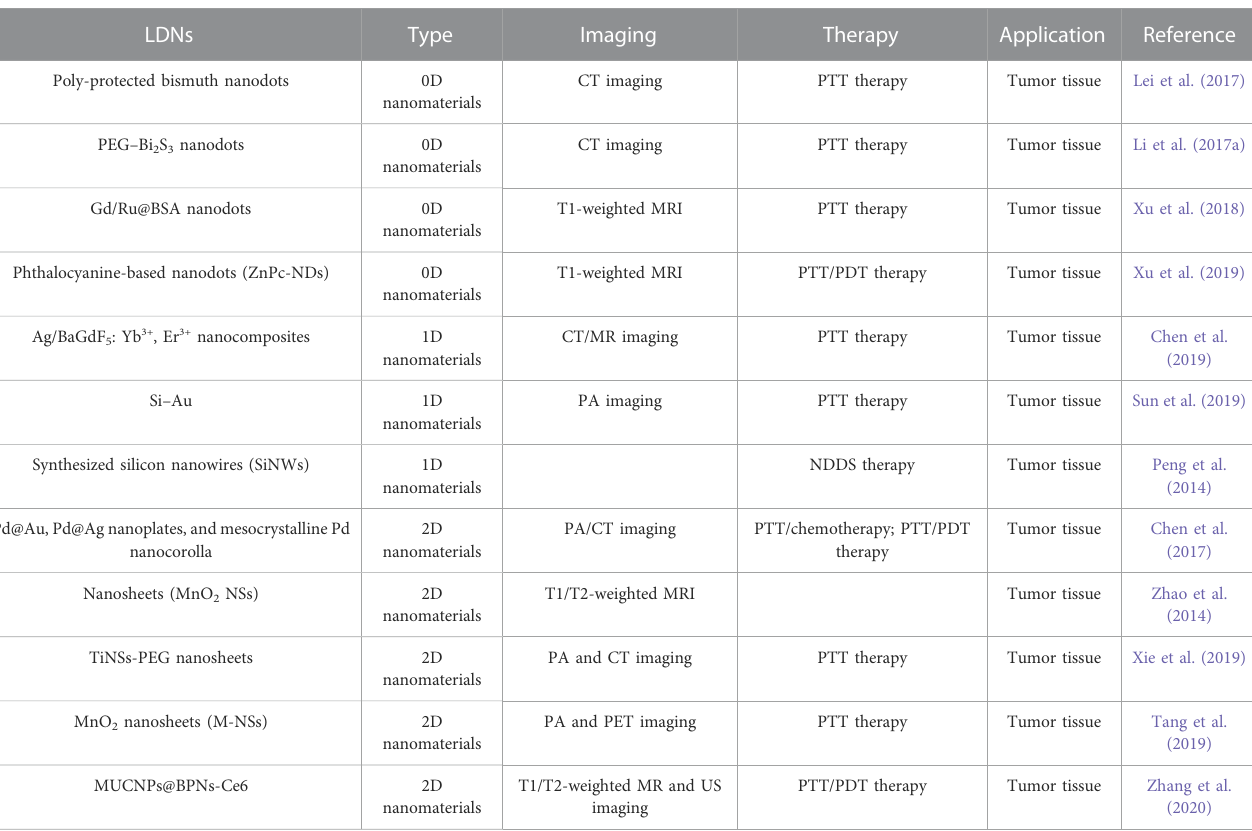
TABLE 1 Illustrative examples of LDNs and their biomedical